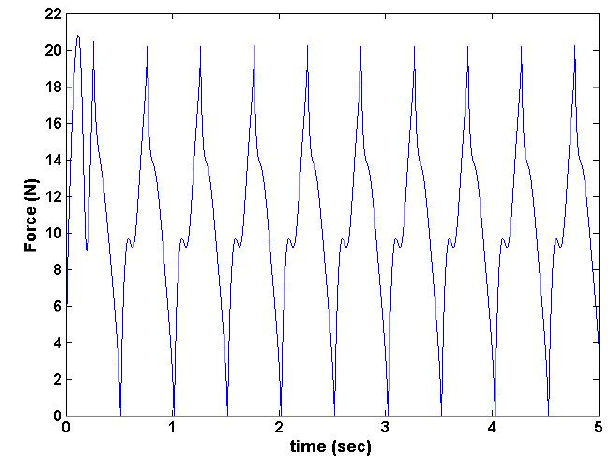
Figure 6. SimMechanics generated waveform showing maximum of 20 N with 2 Hz frequency of the device.